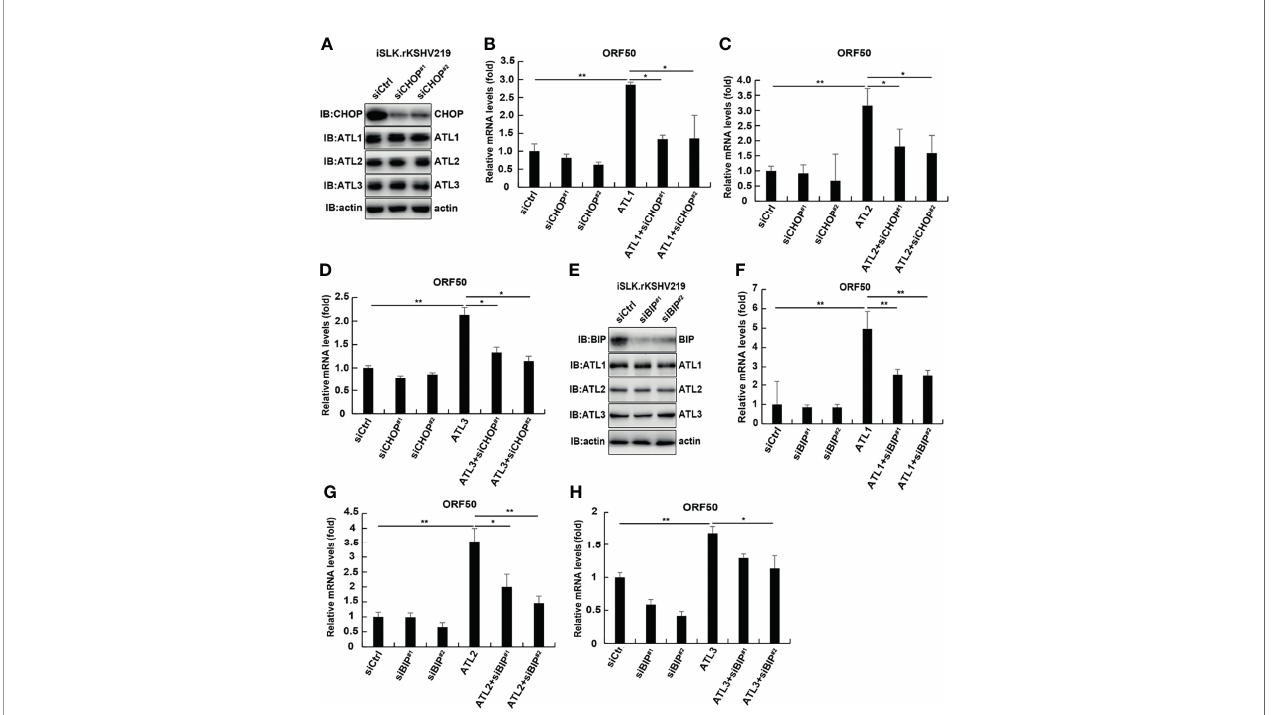
FIGURE 10 | Knockdown of CHOP and BIP can antagonize the promoting effect of ATL proteins on the lytic reactivation of KSHV to a great extent. (A) iSLK.rKSHV.219 cells were transfected with siCtrl, siCHOP #1 , or siCHOP #2 respectively. Forty eight hours later, protein levels of BIP, ATL1, ATL2, and ATL3 were measured by western blot with indicated antibody. (B – D) iSLK.rKSHV.219 cells were transfected with siCtrl, siCHOP #1 , or siCHOP #2 respectively. Six hours later, cells were transfected with ATL1, ATL2, or ATL3 respectively. Forty eight hours later, mRNA levels of KSHV lytic genes ORF50 were measured by RT-qPCR, with normalization to actin using the DD CT method. Data are presented as means of three technical replicates (n = 3, group values are indicated by mean ± SEM; *p <0.05; **p <0.01). (E) iSLK.rKSHV.219 cells were transfected with siCtrl, siBIP #1 , or siBIP #2 respectively. Forty eight hours later, protein levels of BIP, ATL1, ATL2, and ATL3 were measured by western blot with indicated antibody. (F – H) iSLK.rKSHV.219 cells were transfected with siCtrl, siBIP #1 , or siBIP #2 respectively. Six hours later, cells were transfected with ATL1, ATL2, or ATL3 respectively. Forty eight hours later, mRNA levels of KSHV lytic genes ORF50 were measured by RT-qPCR, with normalization to actin using the DD CT method. Data are presented as means of three technical replicates (n = 3, group values are indicated by mean ± SEM; *p <0.05; **p